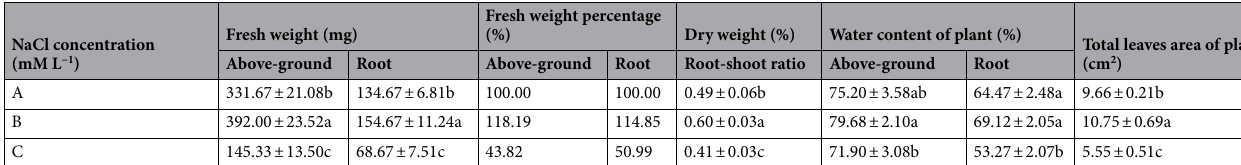
Table 1. Effect of different NaCl concentration treatments on fresh weight, ratio of root, water content and total leaves area of R. soongorica plants. Means of 10 replicates ± S.D. are shown. Values followed by different letters differ significantly according to Duncan’s multiple range tests at P < 0.05. Different lowercase letters indicate that each index is significantly different at different salt concentrations. The same as Fig.